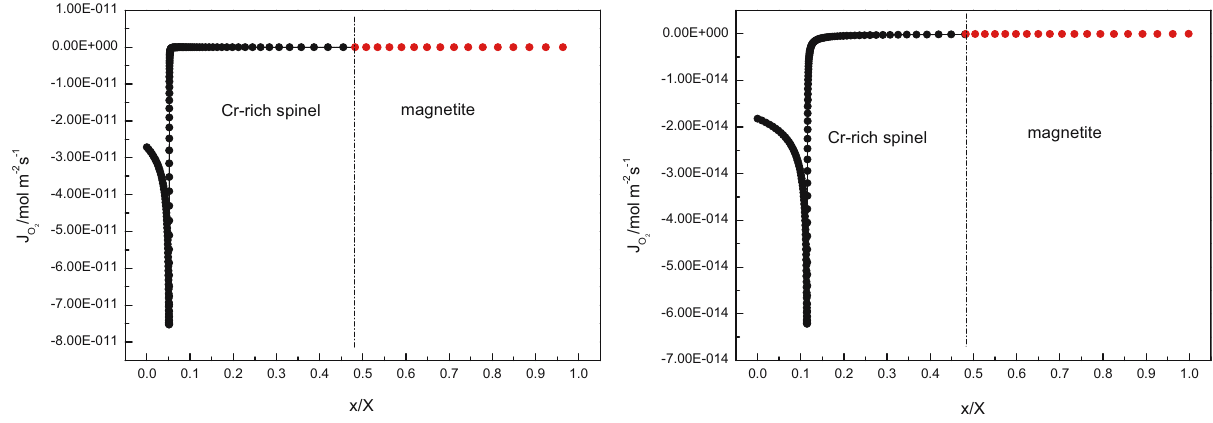
Figure 7: Calculated flux of oxygen ion in oxide scale on HCM12A at 500°C ( left ) and 600°C ( right ) over normalized